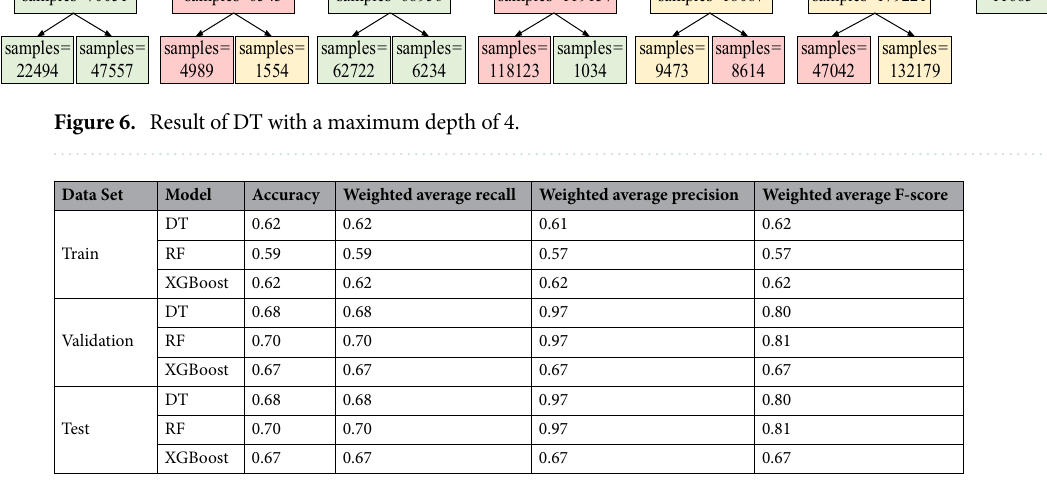
Table 5. The Comparison of traditionally evaluation measures on calibration, validation, and test datasets.